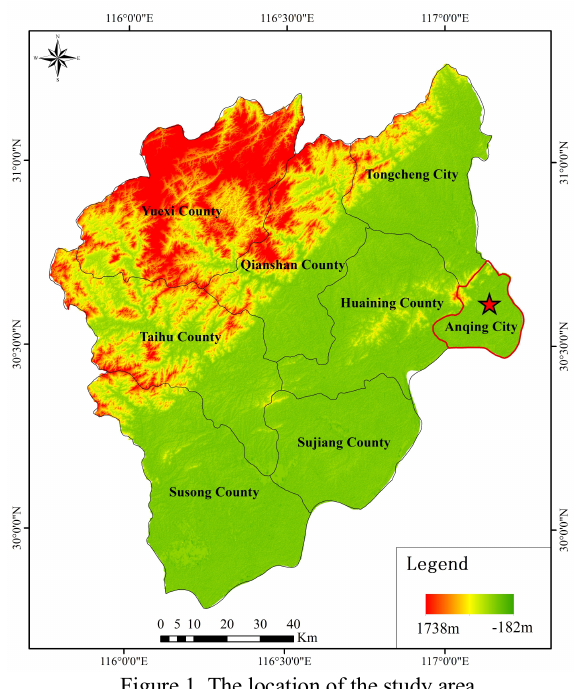
Figure 1. The location of the study area